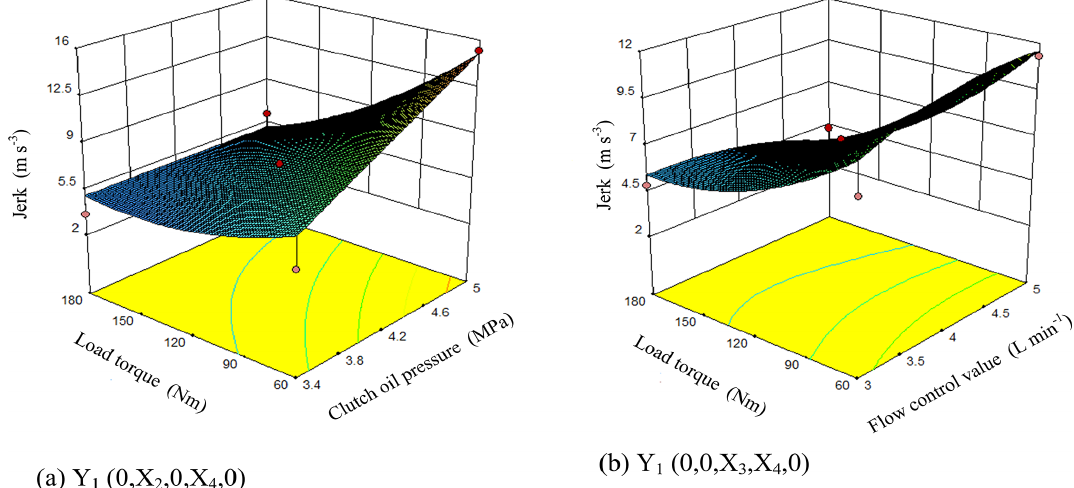
Figure 9. Influence of interaction effect on jerk.